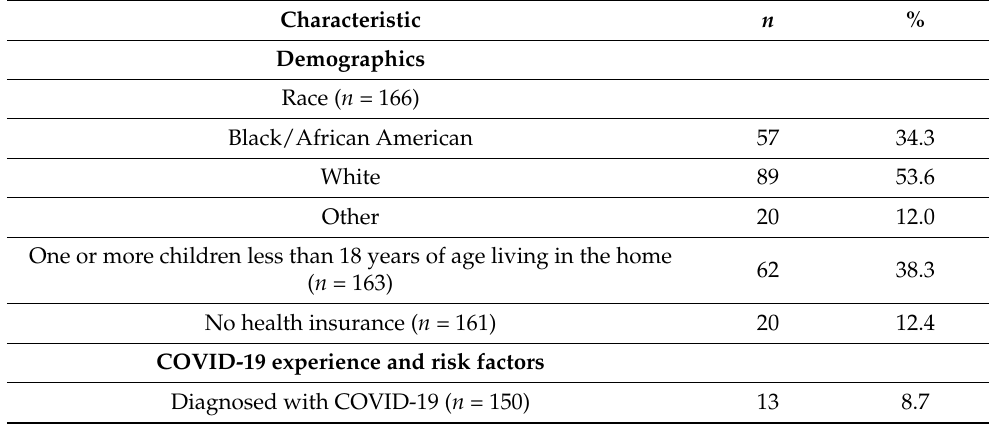
Table 1. Demographics and COVID-19 vaccine status, Delaware Family Child Care Providers,